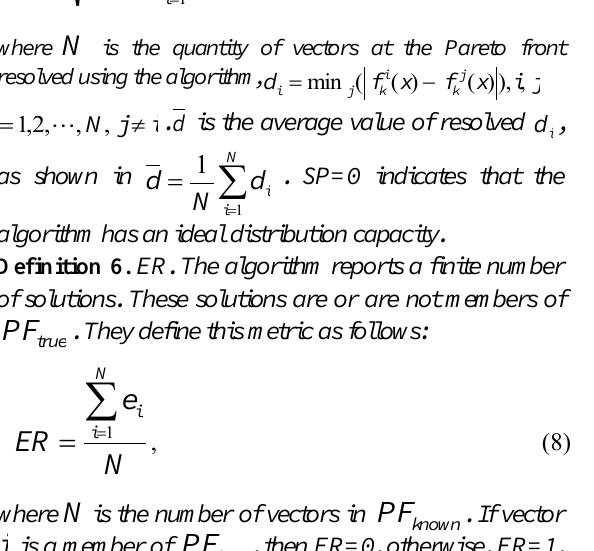
The Pareto front of MOP2 is discontinuous. Figure 2 shows the curve of the Pareto front obtained using the IPMA.